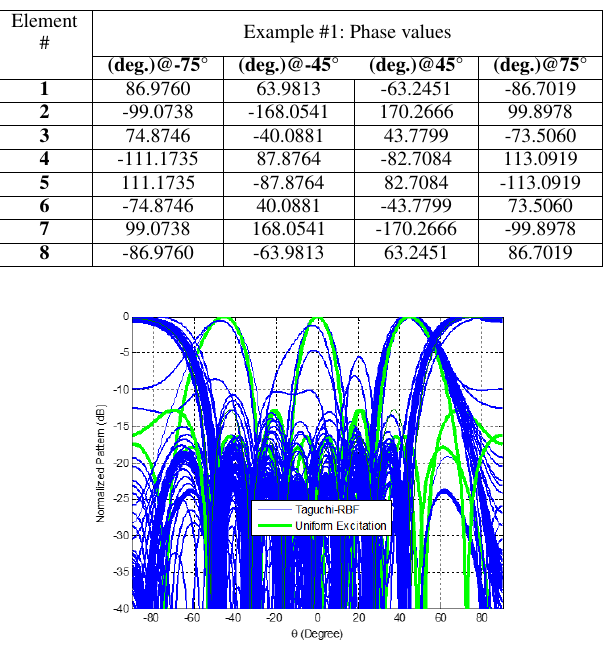
FIGURE 18. Radiation patterns of 8 Antipodal Vivaldi antenna@-75°,-45°, 0°, 45°, 75° and frequency 5.8 GHz.